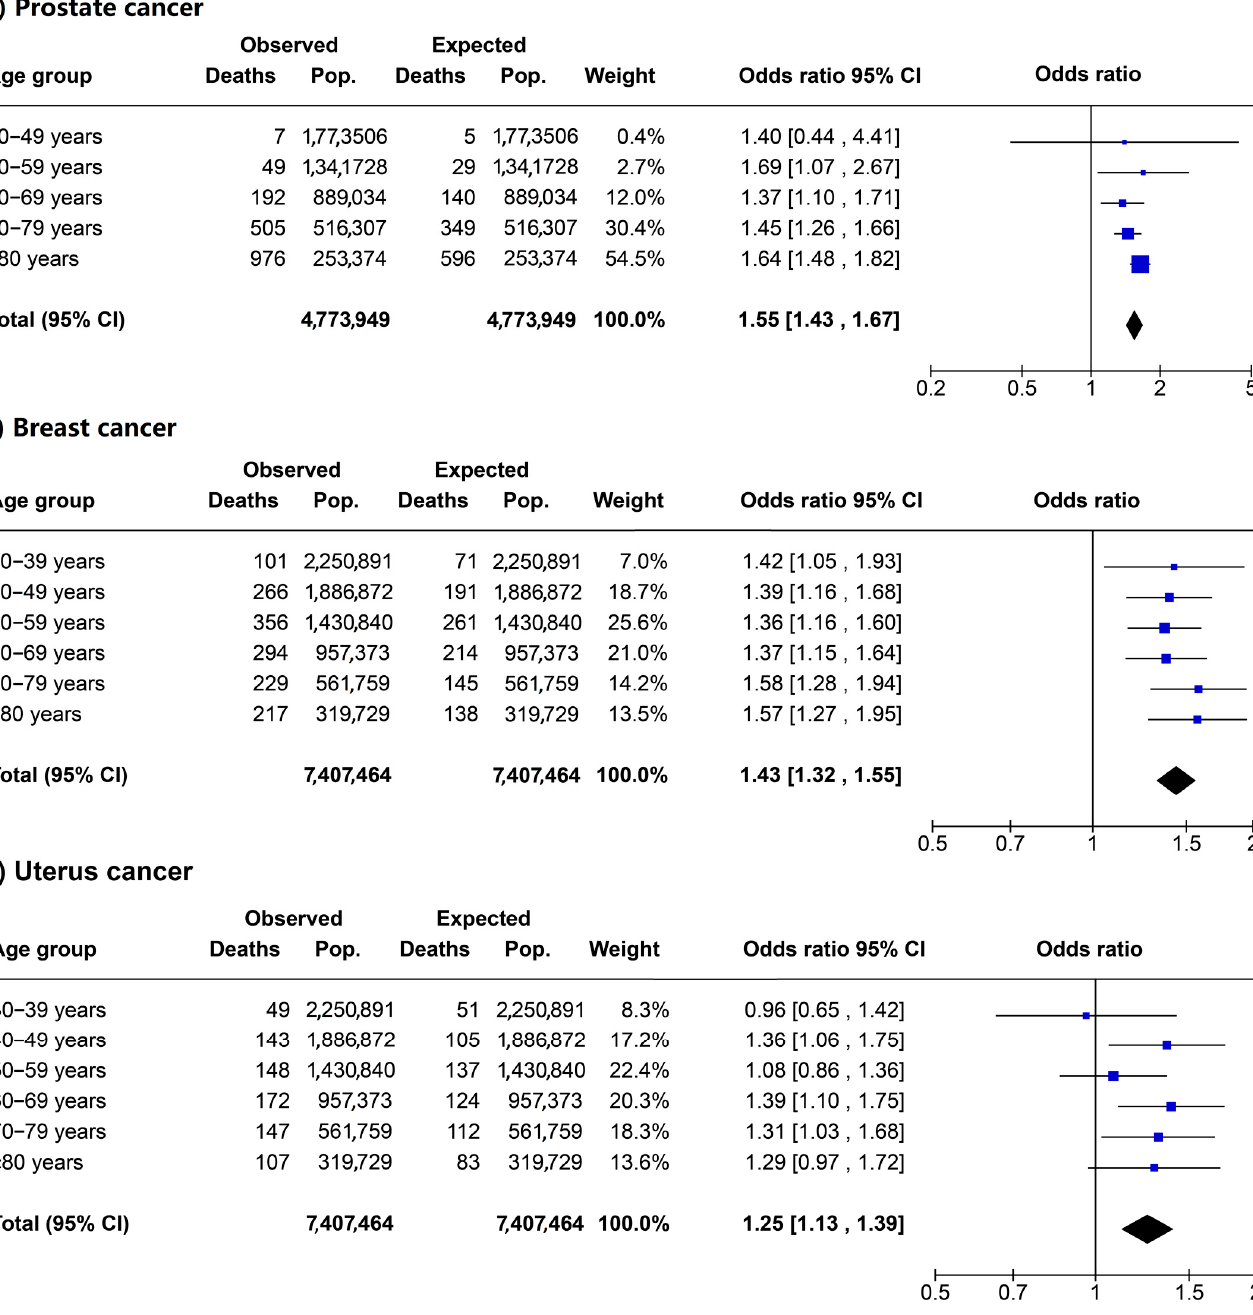
Figure 6. Odds ratio for excess deaths stratified by age for ( A ) prostate cancer, ( B ) breast cancer, and ( C ) uterus cancer in Peru. Observed deaths in 2020 vs. expected deaths in 2020.